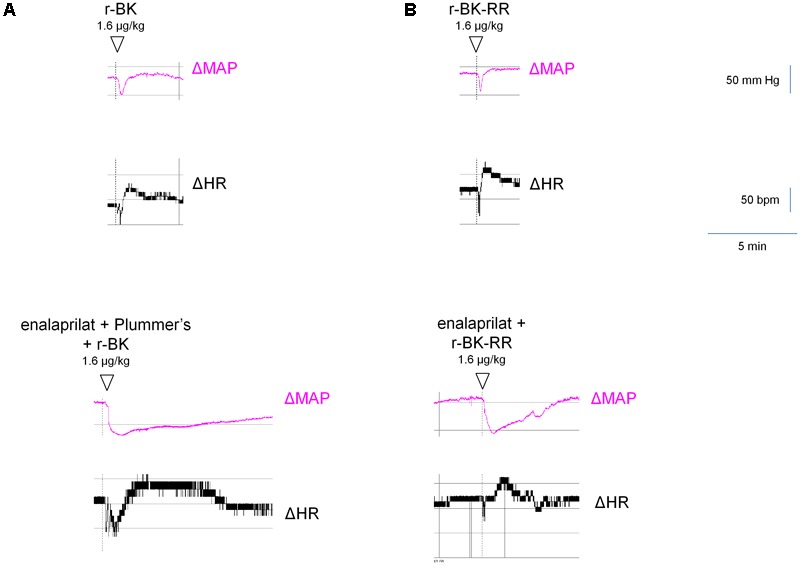
Representative traces showing the mean arterial blood pressure and heart rate responses to i.v. bolus injections of r-BK (A) or r-BK-RR (B) at the dose of 1.6 μg/kg in untreated and drug-pretreated anesthetised rats. Enalaprilat (0.1 mg/kg), with or without Plummer’s inhibitor (0.75 mg/kg) as indicated, was i.v. given as bolus 15 min before starting the injections of r-BK or r-BK-RR. Abscissa: time; ordinate: arterial pressure (mm Hg).